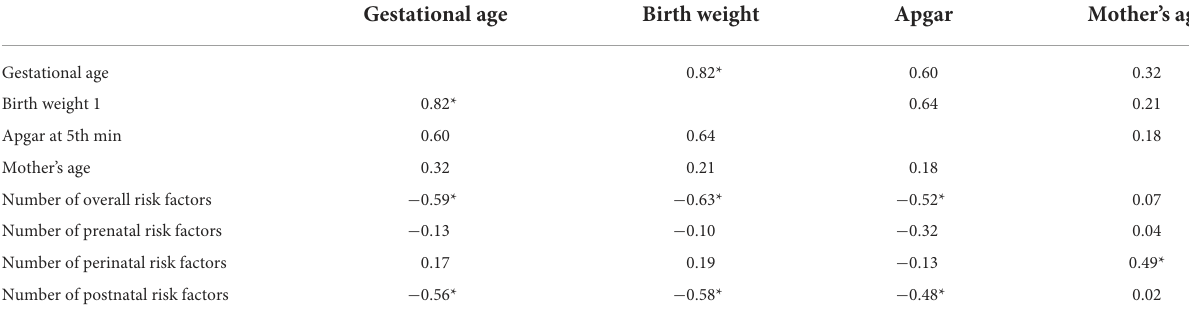
TABLE 3 Spearman’s rank correlation coefficient (Spearman’s ρ ).